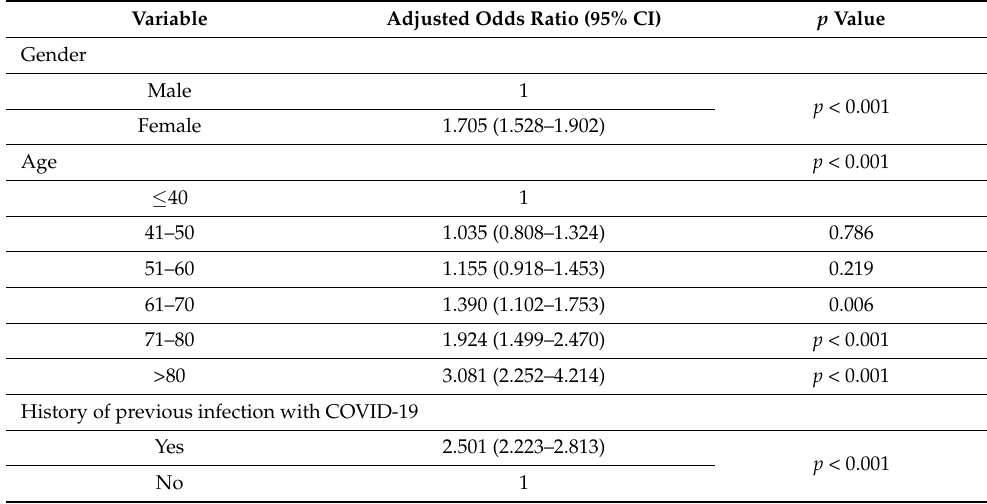
Table 5. Binary logistic regression for factors associated with unvaccinated status of the